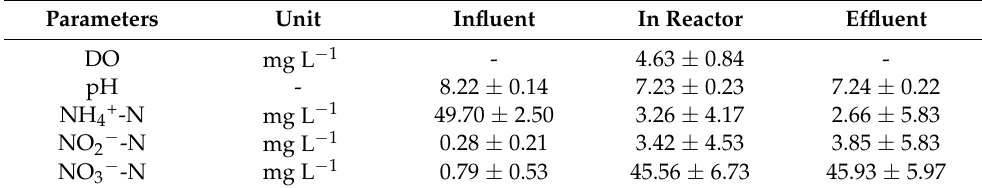
Table 1. Reactor performance in a GMBR at steady state on the 305th day.